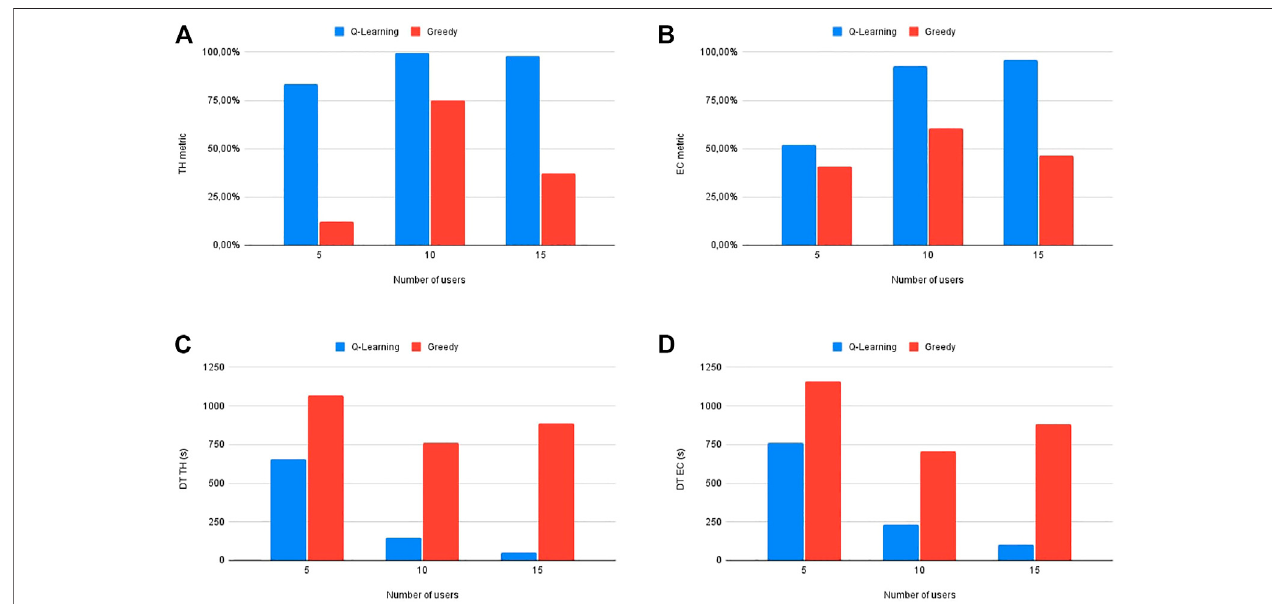
FIGURE7| Comparativerepresentation(seealso Table3 )betweenQ-learningandgreedyalgorithmperformanceconsidering (A) THmetric, (B) ECmetric, (C) TH Delivery Time, and (D) EC Delivery Time.